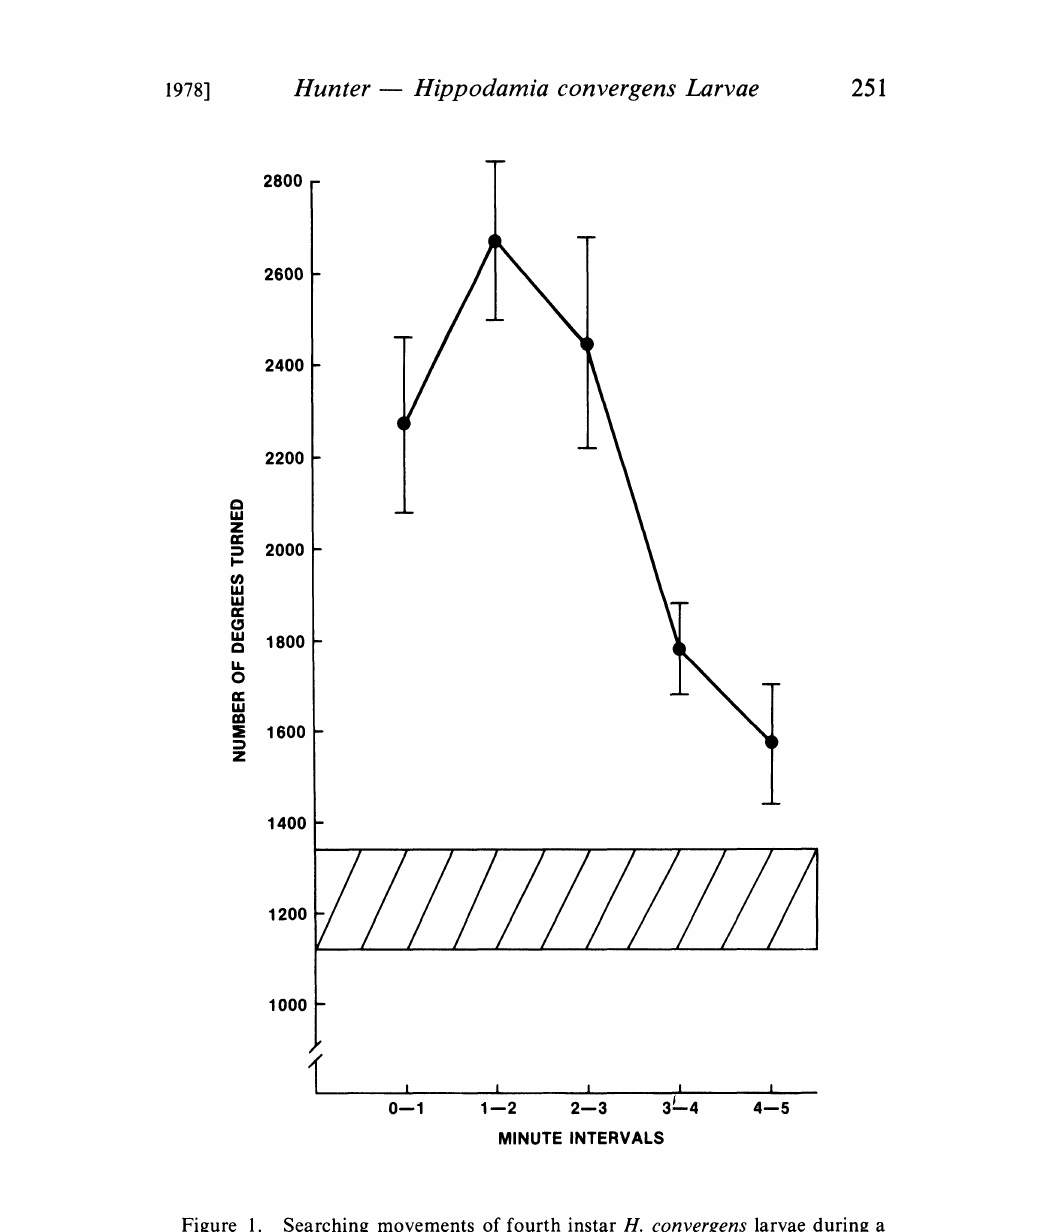
Figure 1. Searching movements of fourth instar H. convergens larvae during a five minute interval before and after consuming one adult T. maculata. The bar represents the cumulative mean + one standard deviation of the numbers of degrees turned by larvae for five 1-minute-intervals prior to